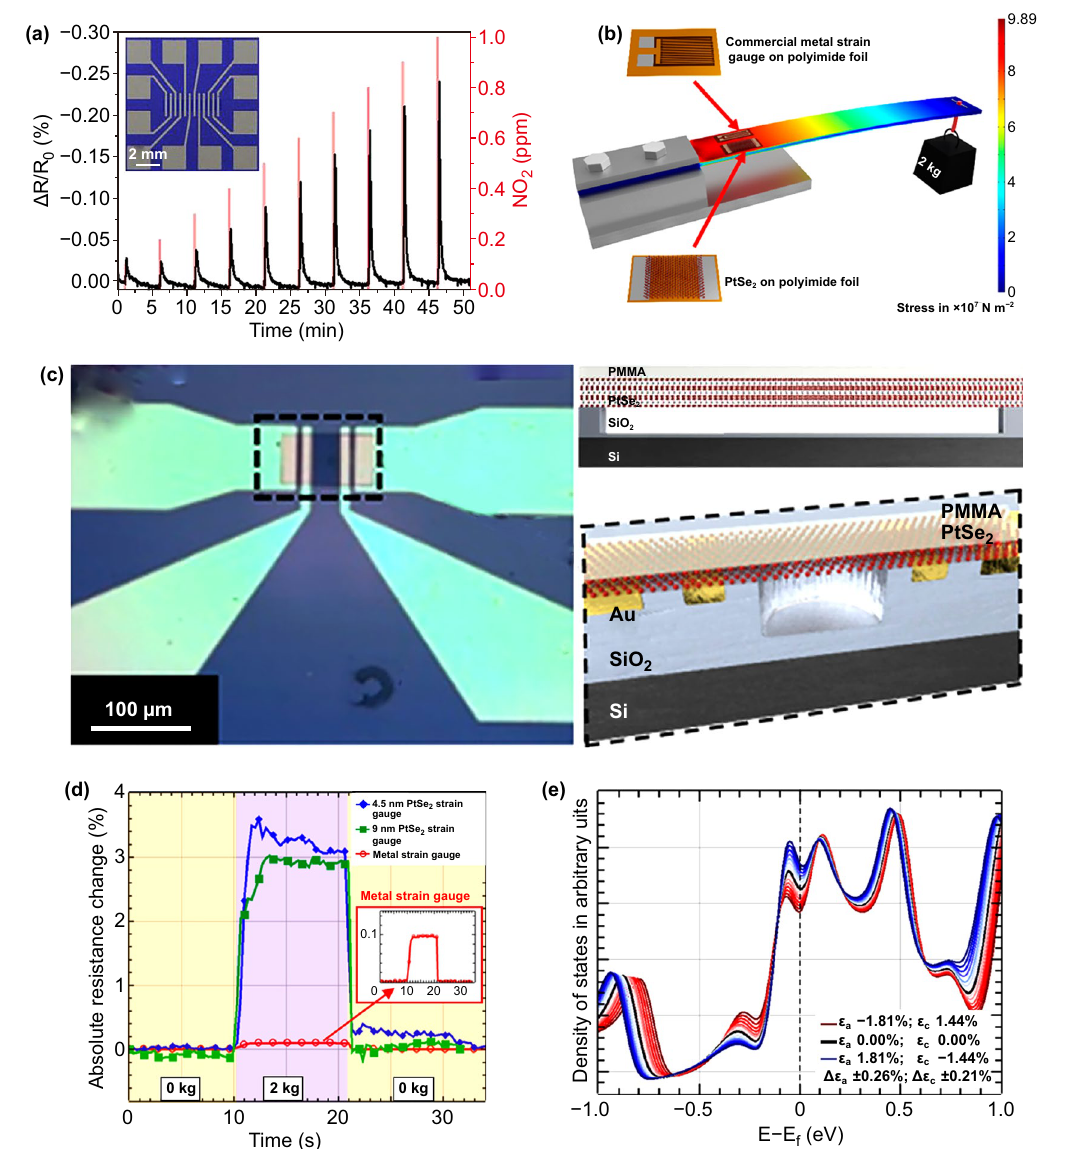
Fig. 15 Performance of 2D PtSe 2 ‑based Sensors. a Gas sensor response of PtSe 2 film upon periodic NO 2 gas (0.1 to 1 ppm) exposure versus time with a bias voltage of 1 V. Red line indicates NO 2 gas injections, and black line indicates the resistance change. Inset shows an optical microscopic image of a contacted sensor device. Reproduced with permission [112]. Copyright 2016, American Chemical Society. b Bending beam setup with applied PtSe 2 film and commercially available metal strain gauges including stress simulation with the applied weight. c Optical microscopic image (left) of the pressure sensors with the PtSe 2 channel across the cavity area. Structure diagram (right) of the cross section of the cavity area with suspended PtSe 2 film. d Measured resistance changes during the measurement against time e Effect of the applied interlayer tensile strain ( ε a ) and compression ( ε c ) on the density of states close to the Fermi level. b–e Reproduced with permission [122]. Copyright 2018, American Chemical